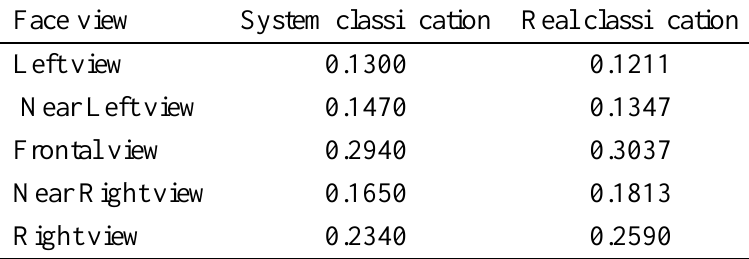
Table 3. Face pose percentages on the cVSG corpus.